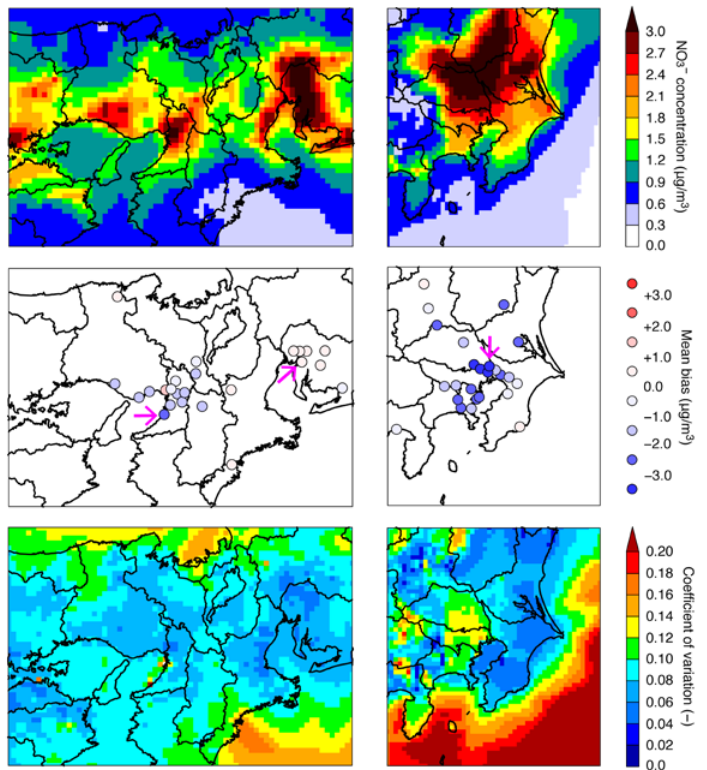
Figure 4. Spatial distributions of (top) the ensemble mean, (center) the mean bias between observations and the ensemble mean, and (bottom) the coefficient of the variation over (left) domain 3 and (right) domain 4. The sites indicated by pink arrows in the center panel were used for further analysis (see also Figure 2).